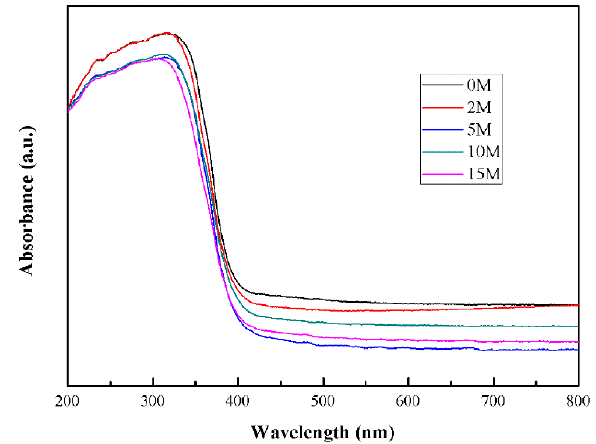
Figure 3. Optical absorption spectra of catalysts.